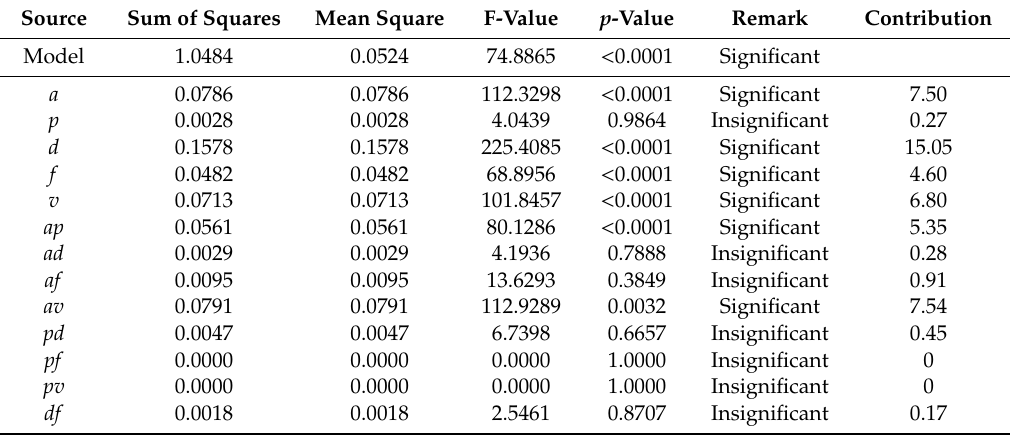
Figure 11. The interactive effects of machining parameters on the improved hardness ratio. Table 5 shows the contributions of the inputs for the improved hardness rate. As a result, the diameter has the largest contribution (15.05%), followed by the depth of cut (7.50%), speed (6.80%), and feed rate (4.60%), respectively. The contributions of the a 2 , p 2 , d 2 , f 2 , and v 2 are 14.20%, 12.60%, 12.27%, 8.59%, and 2.64%, respectively. Table 5. ANOVA results for improved hardness